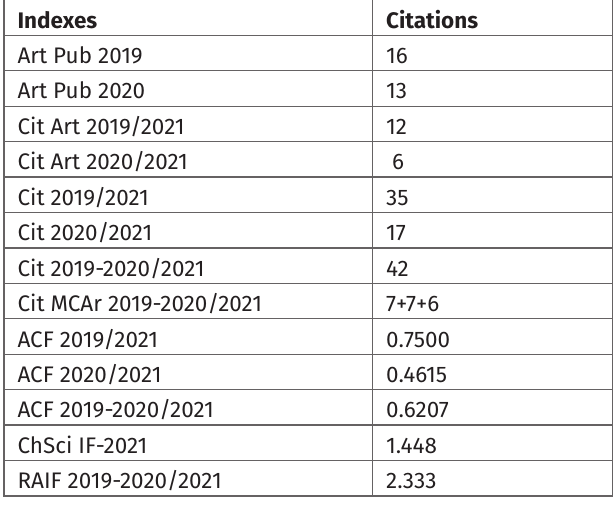
Table I. Citations and indexes concerning the articles published in Chemical Sciences by the Annals of the Brazilian Academy of Sciences in 2019 and 2020 that have been considered in the Impact Factor of 2021.